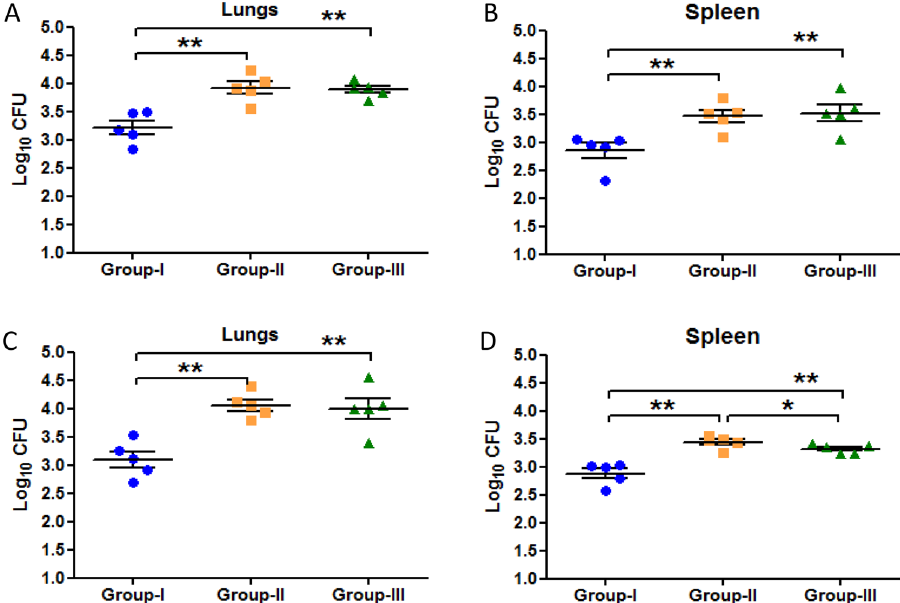
Figure 1. CFU enumeration of M. tuberculosis H37Rv in latent tuberculosis after diabetes development. Log 10 CFU counts in lungs and spleen of mice from Group-I, Group-II and Group-III at different time points of streptozotocin treatment. ( A ) Lungs after 9 weeks ( B ) Spleen after 9 weeks ( C ) Lungs after 13 weeks ( D ) Spleen after 13 weeks of streptozotocin treatment. The data were represented as Mean ± SE of 5 animals in each group and the statistical significance was determined by Mann–Whitney test. **p ≤ 0.01, *p ≤ 0.05. Group-I: latent tuberculosis only, Group-II: latent tuberculosis with diabetes and Group-III: latent tuberculosis with immunosuppression. Animal model was developed only once but CFU enumeration was done in triplicates from each